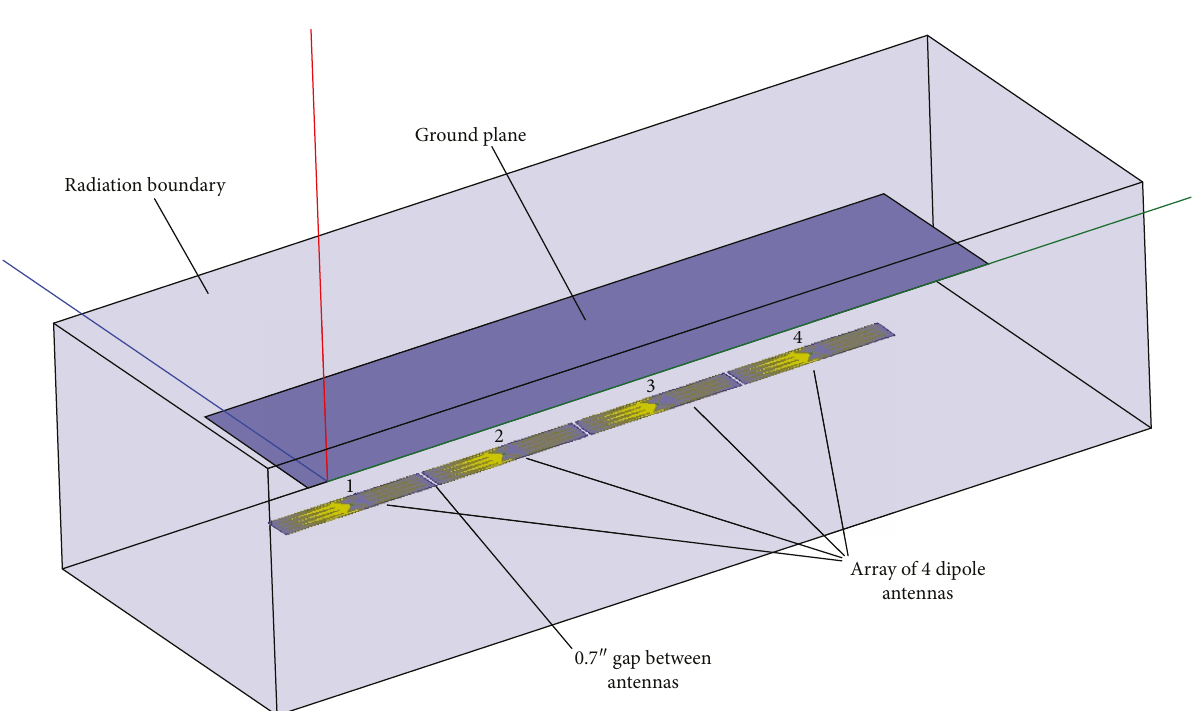
Figure 19: Four element dipole antenna